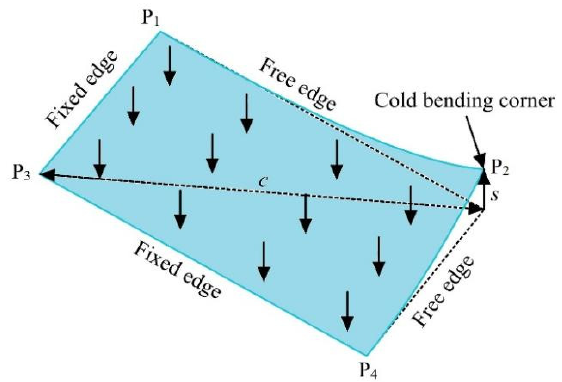
Figure 1. Schematic diagram of cold bending and uniform load.